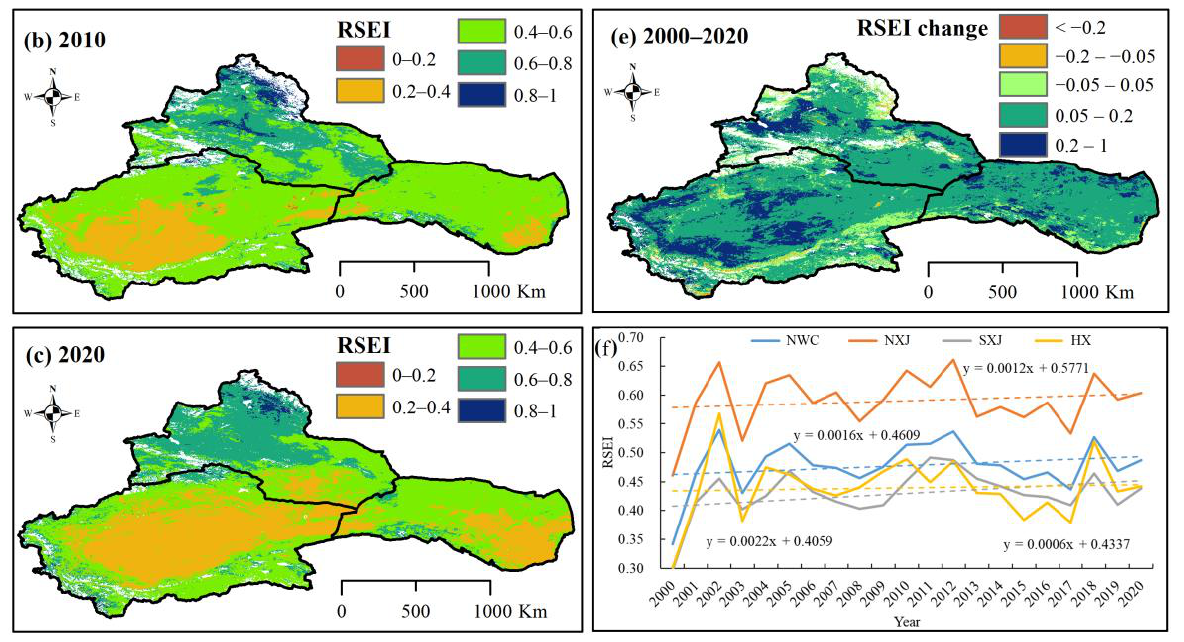
Figure 10. Spatial distribution and variations of RSEI from 2000 to 2020. Spatial distribution in RSEI during ( a ) 2000, ( b ) 2010, and ( c ) 2020; ( d ) spatial variations of RSEI during 2000 − 2020; ( e ) spatial variations of RSEI between 2000 and 2020; ( f ) temporal variations of RSEI in NWC during 2000 −2020 .